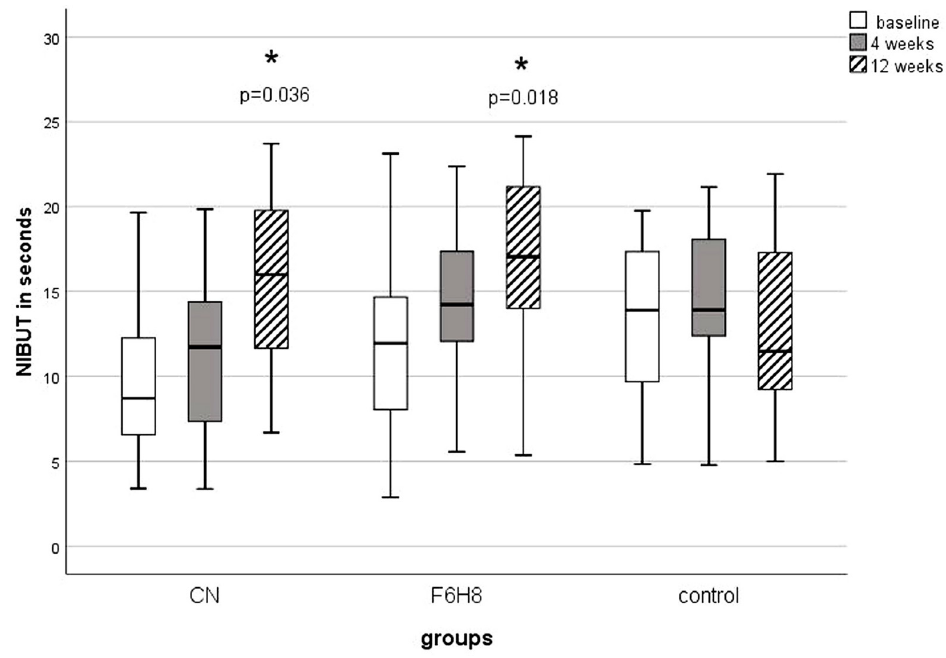
Fig 6. NIBUT at baseline and consecutive measurements. The NIBUT at 4 and 12 weeks were compared with the NIBUT of the baseline using the Wilcoxon test. All p-values were adjusted for 2 comparisons according to the Bonferroni method. An asterisk with the corresponding p-value indicates a significant change compared to the baseline. NIBUT = non-invasive tear break-up time; CN = cationic nanoemulsion; F6H8 =